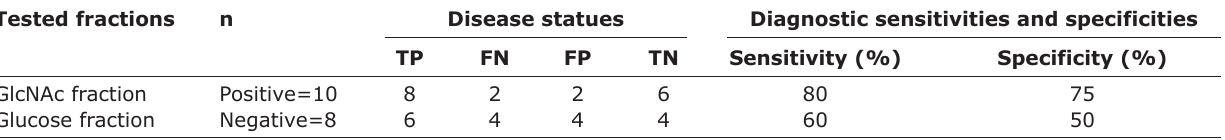
Table-1: Specificity and sensitivity of isolated T. vitulorum glycoproteins for diagnosis of calves’ toxocariasis. Tested fractions n Disease statues Diagnostic sensitivities and specificities